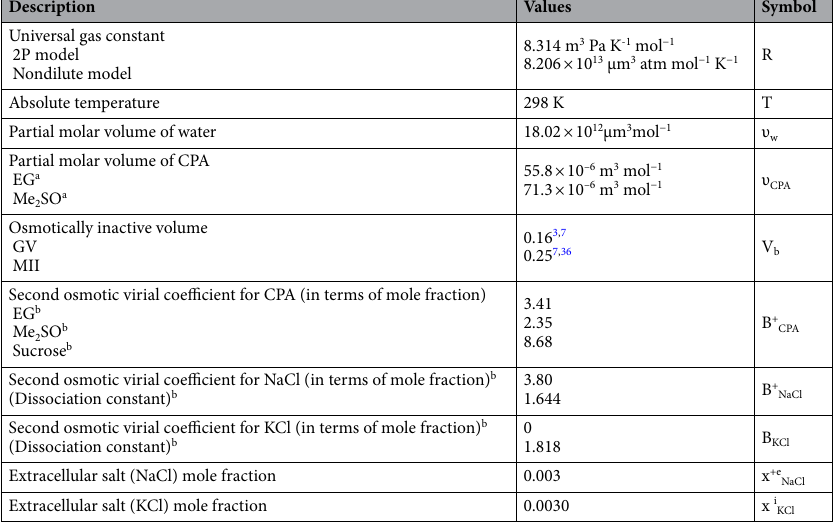
Table 5. Constant and parameters used in 2P model and nondilute solution model. a Partial molar volumes of cryoprotectants from Vian et al. 56 . b Second osmotic virial coefficient and dissociation constants from Zielinski et al. 57 . Abbreviations: CPA cryoprotectant, EG ethylene glycol, Me 2 SO dimethyl sulfoxide, GV germinal vesicle, MII metaphase